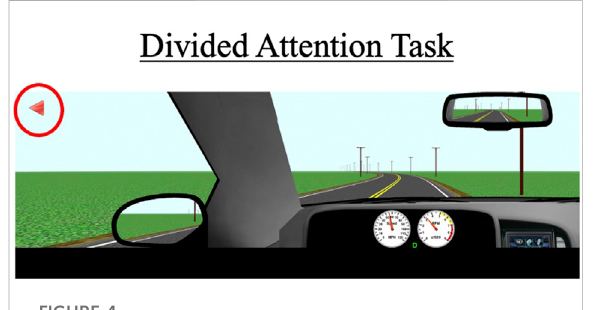
FIGURE 4 The divided attention task with arrows (red circle) that appear on the left and right monitor displays. Participants must press the corresponding buttons (see Figure 2) within a 5-s timeframe to receive a “ correct ” response. The primary outcomes for this scenario are SDLP, standard deviation of speed (SDSP), the percentageof correct responses, and the average reaction time to the 20